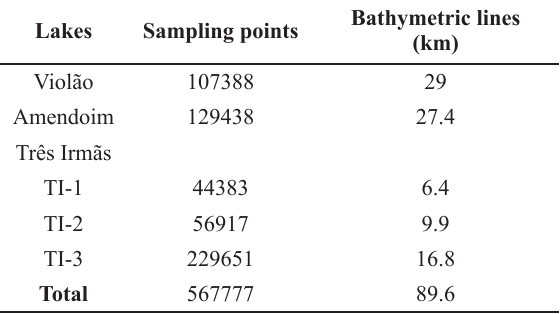
Sampling points and lines generated during the bathymetric surveys of the studied